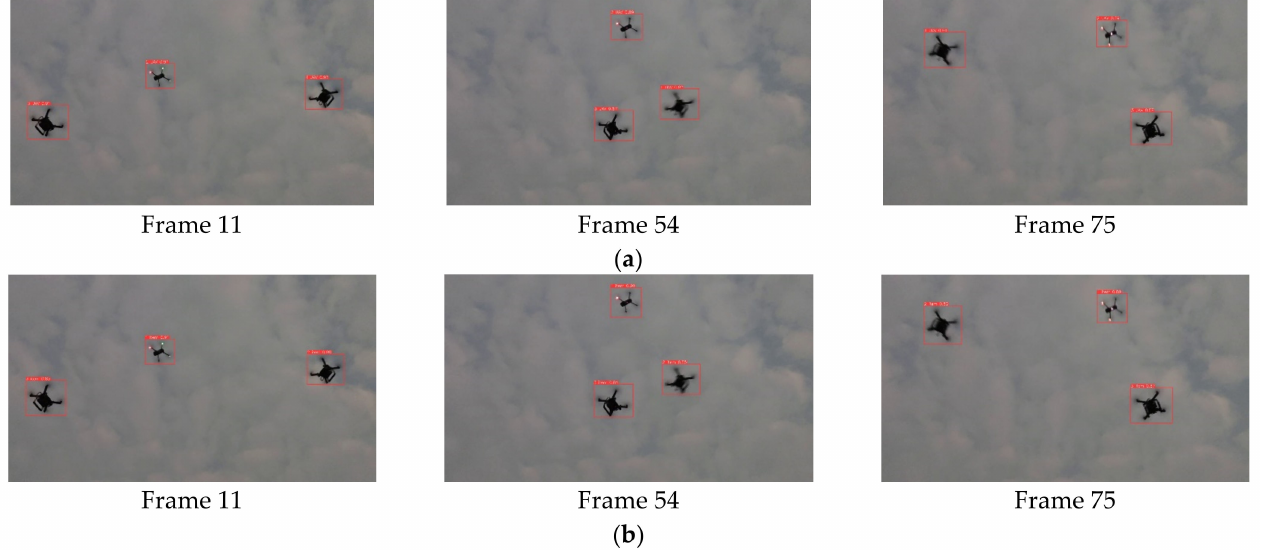
Figure 11. Algorithm tracking effect of UAVs in stable flight. ( a ) YOLOv5 + Deepsort; ( b ) improved YOLOv5 + Deepsort.